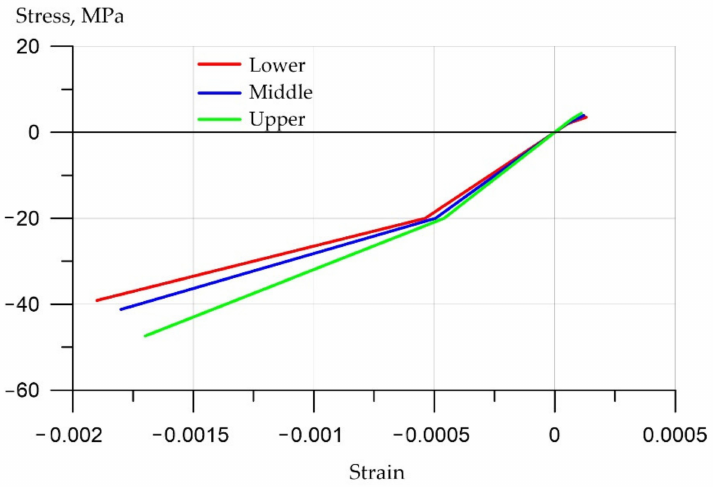
Figure 2. Bilinear stress-strain curves for the bottom, middle and top layers of concrete (negative stress values characterize